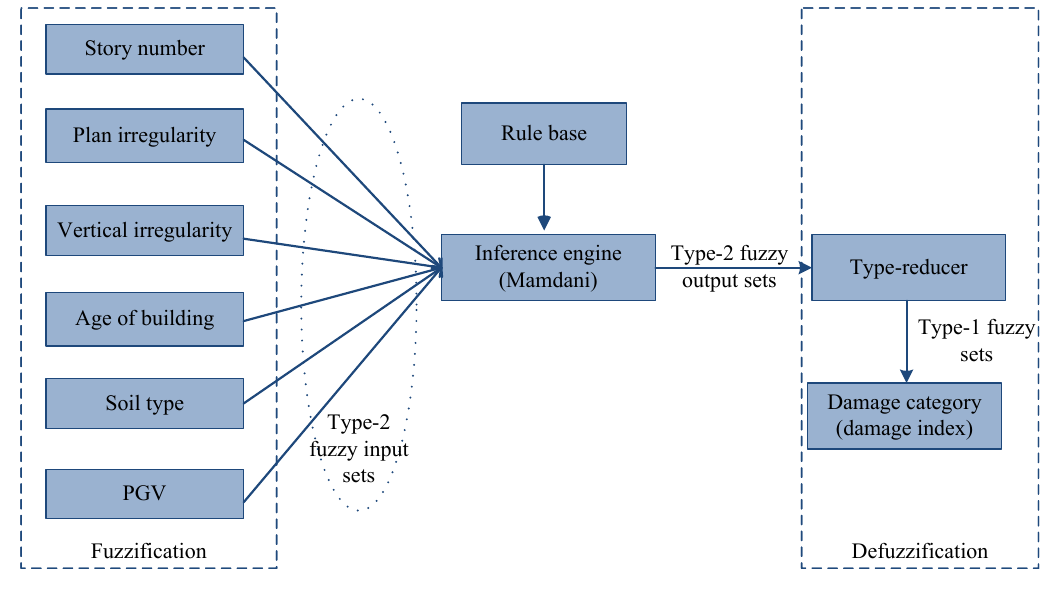
Figure 1. The structure of the proposed RVS based on